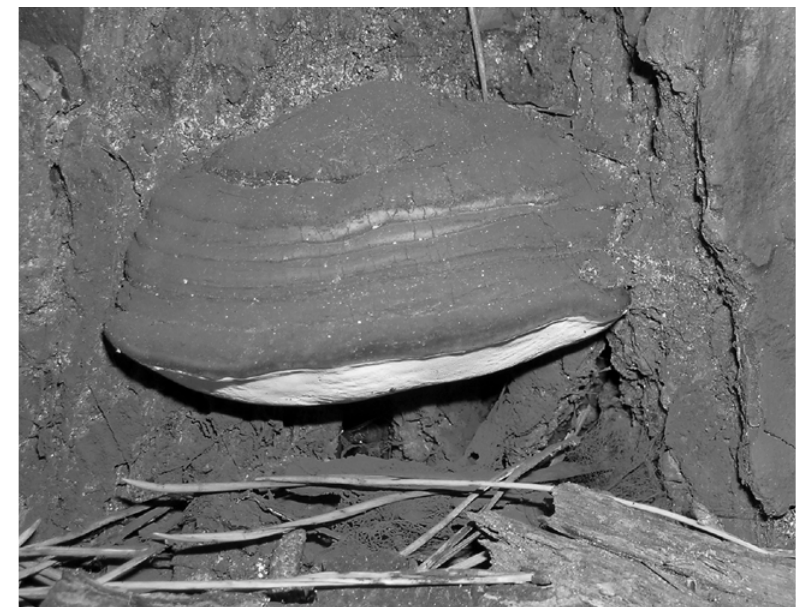
Figure 1. Sporocarps of Ganoderma adspersum at the base of a trunk of Pinus pinea